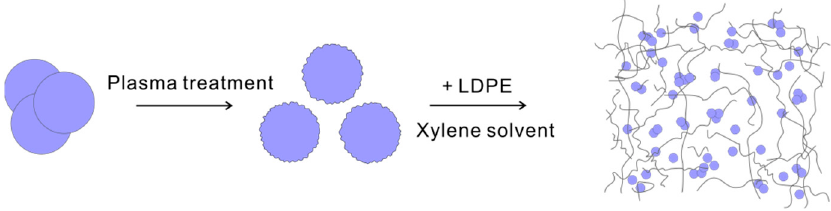
Figure 5. NPs treated by plasma were mixed with LDPE in xylene solvent.